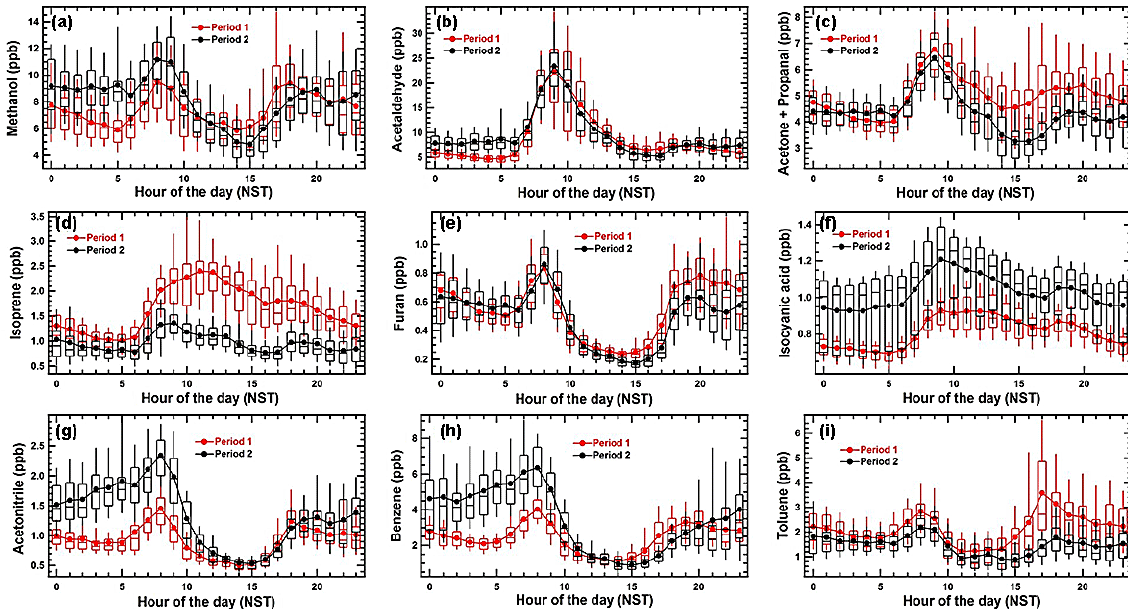
Figure 6. Box and whisker plots showing average, median and variability (10th, 25th, 75th and 90th percentile) for some major VOCs in the Kathmandu Valley during period 1 and period